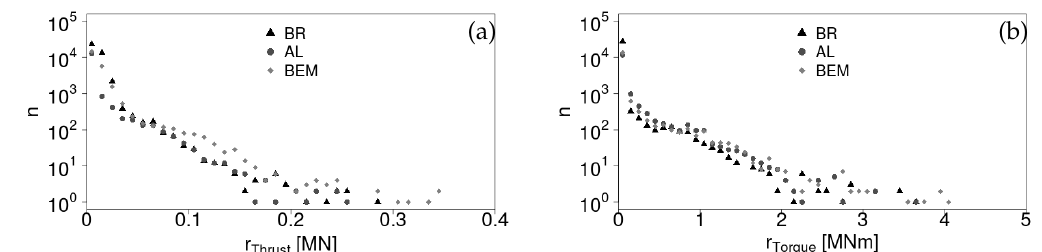
Figure 14. Range histograms for ( a ) thrust and ( b ) torque.